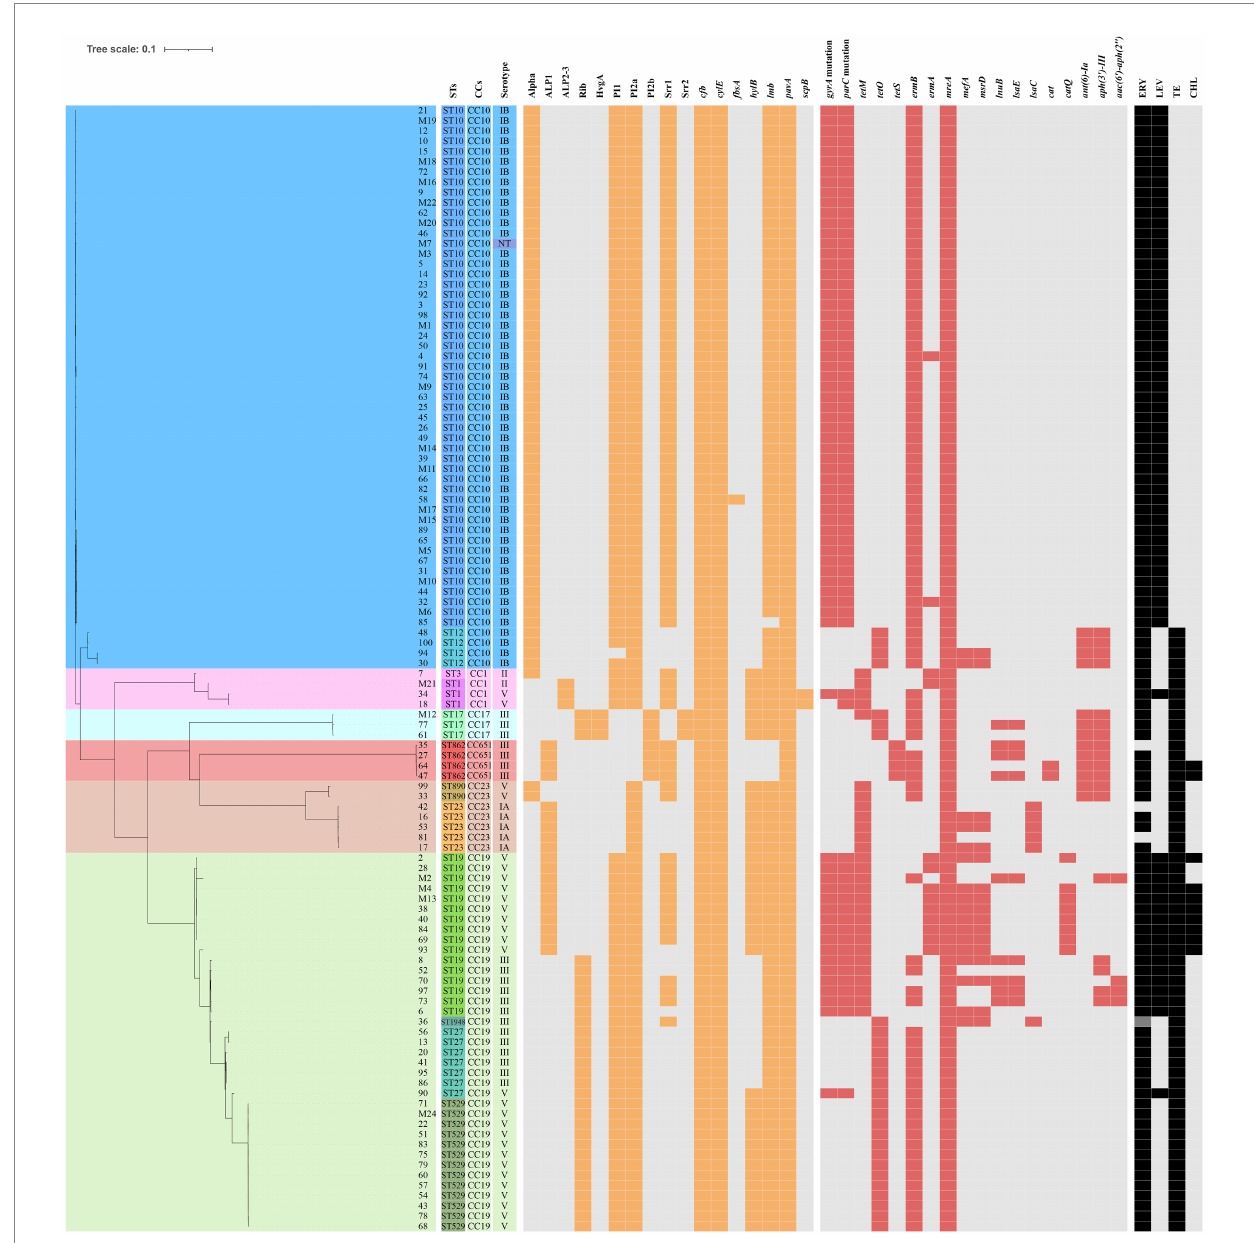
FIGURE 3 Core genome of the 110 strains of S. agalactiae. SNP (Single nucleotide polymorphism) maximum-likelihood phylogenetic tree and heat map showing the virulence and resistance genes. The rectangular block of different colours represents STs, CCs, and serotypes. The spaces are filled in orange or red if the strain harboured the resistance genes or virulence factors, respectively. The rectangular blocks were filled in black when strains had resistant profiles to erythromycin (ERY), levofloxacin (LEV), tetracycline (TE), and chloramphenicol